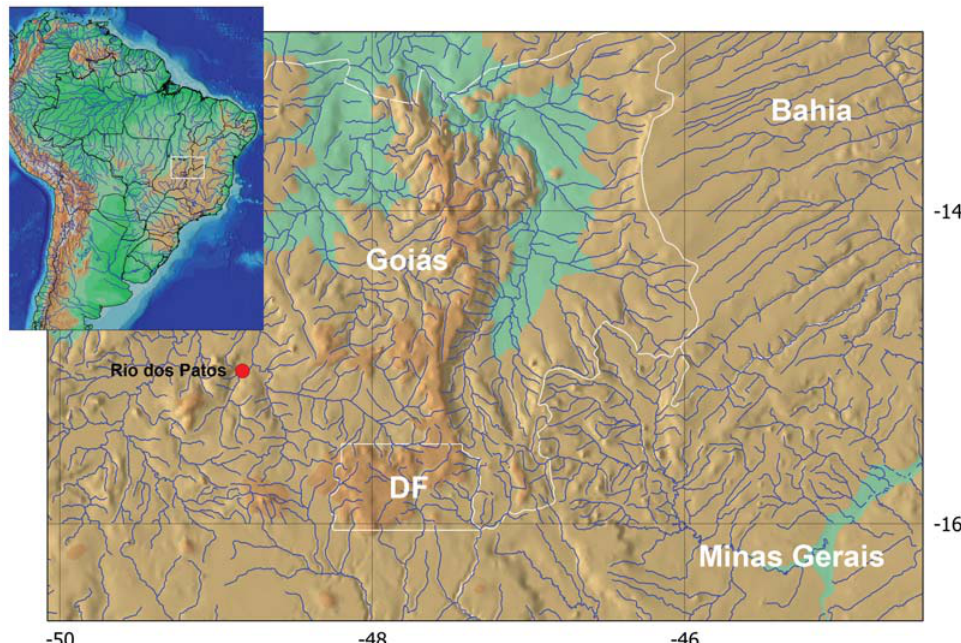
Fig. 4. Type locality of Microglanis maculatus (red circle), ribeirão Pouso Alegre, tributary of rio dos Patos, upper rio Tocantins basin, Barro Alto, Goiás State, Brazil.